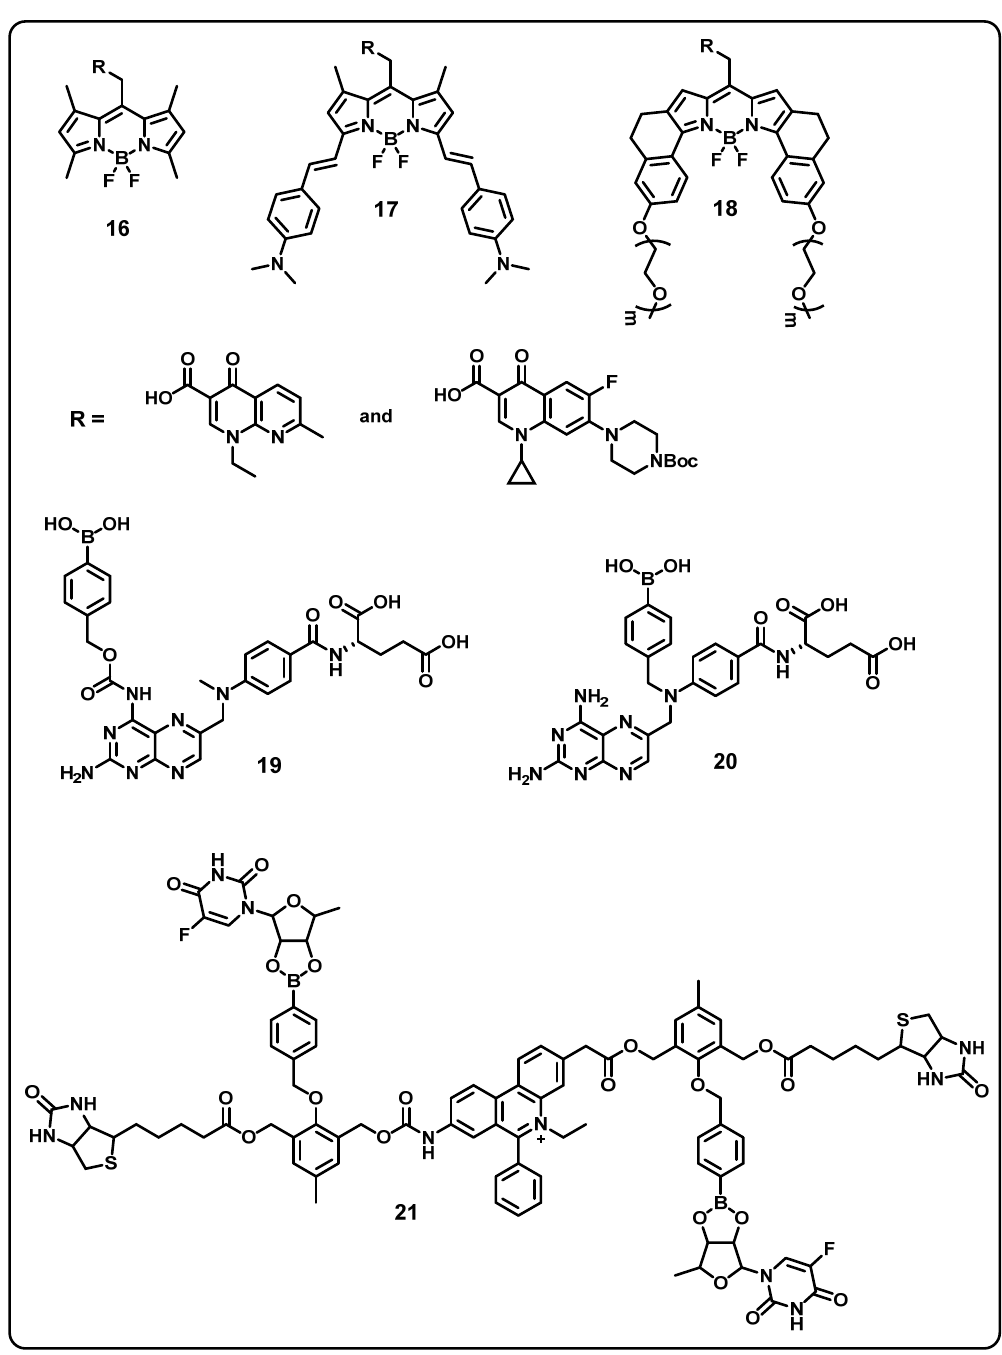
Figure 12. Structure of BODIPY-based quinolone release ( 16 – 18 ) and prodrug ( 19 – 21 ).